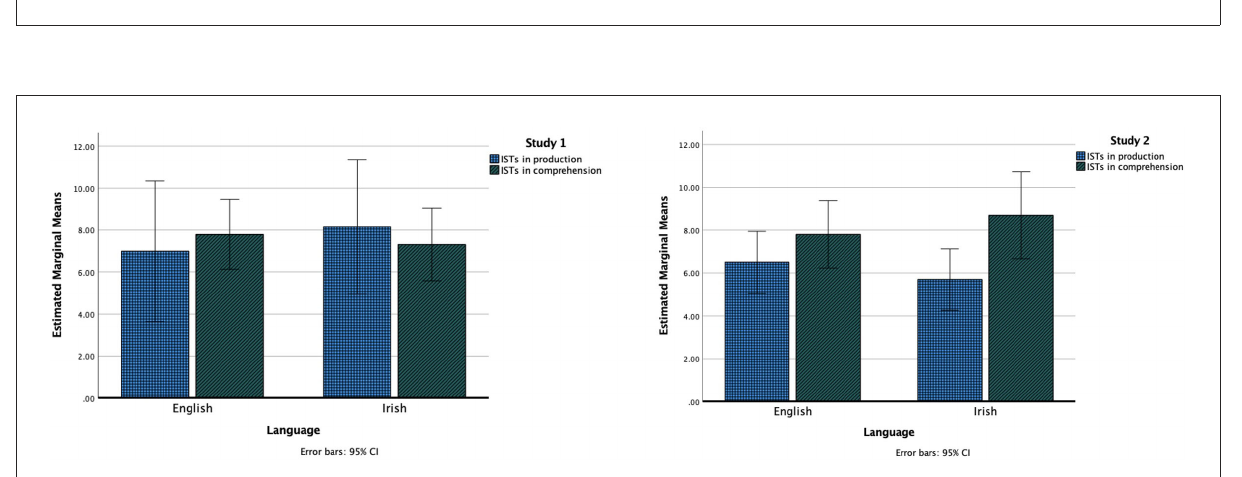
FIGURE2 The internal state terms (ISTs) in production and comprehension across Irish and English in Study 1 and Study 2.